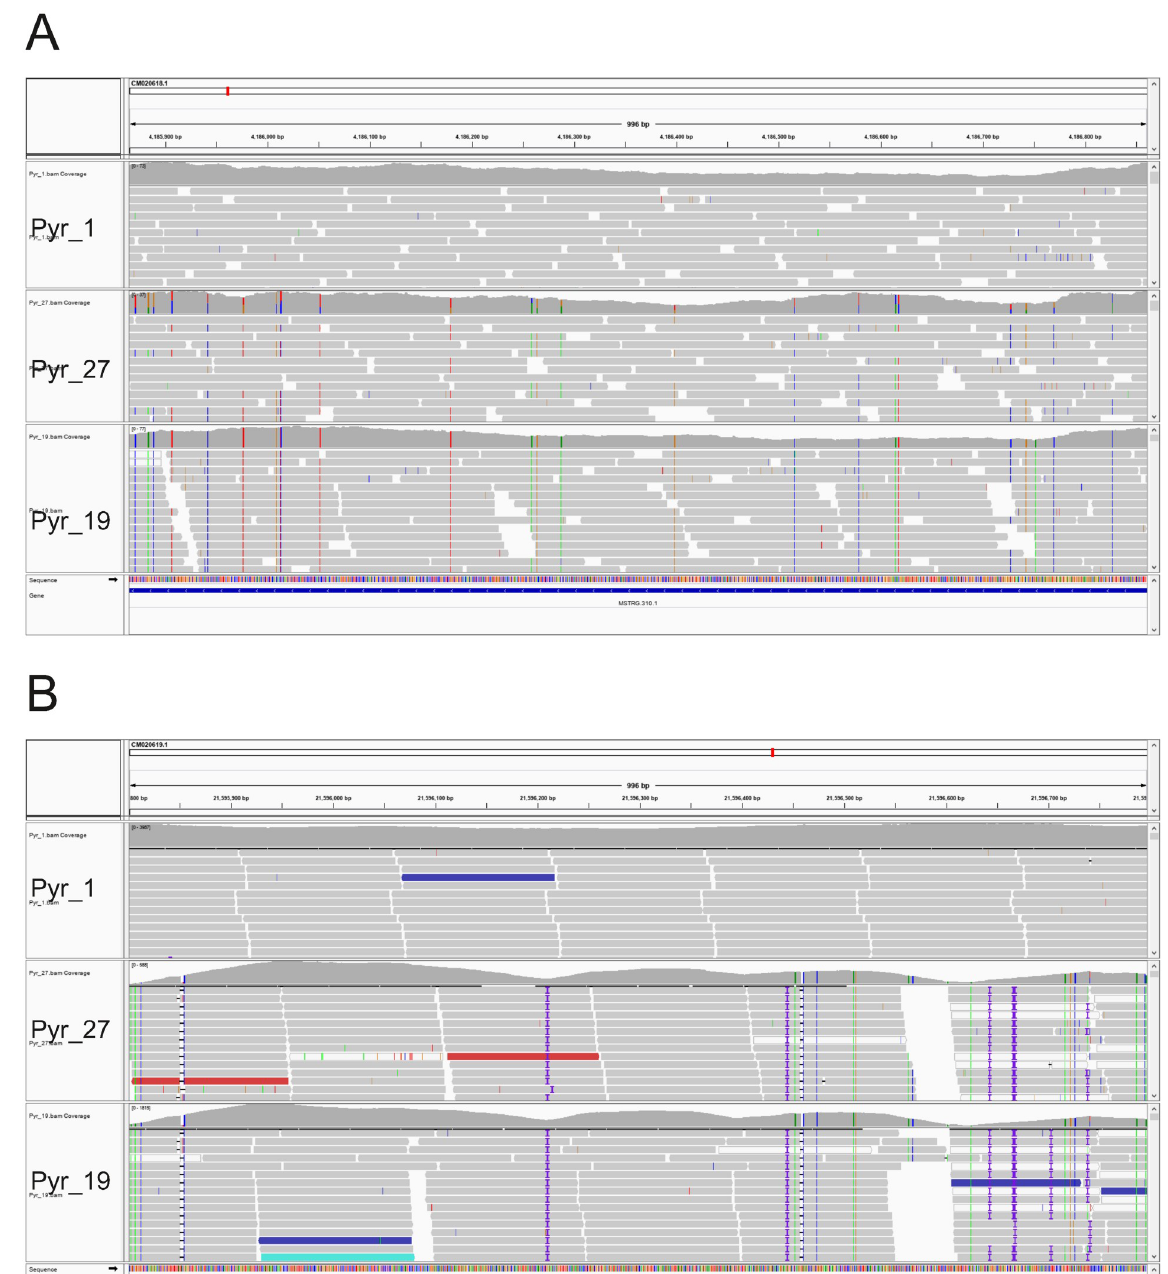
Fig 4. Comparison of the nuclear genotypes of Pyr_1 ( Pyropia yezoensis ), Pyr_27 (the hybrid between P . yezoensis and P . tener a), and Pyr_19 ( P . tenera ) visualized by the Integrative Genomics Viewer. (A) A representative example of allotetraploid formation. (B) Nuclear rRNA